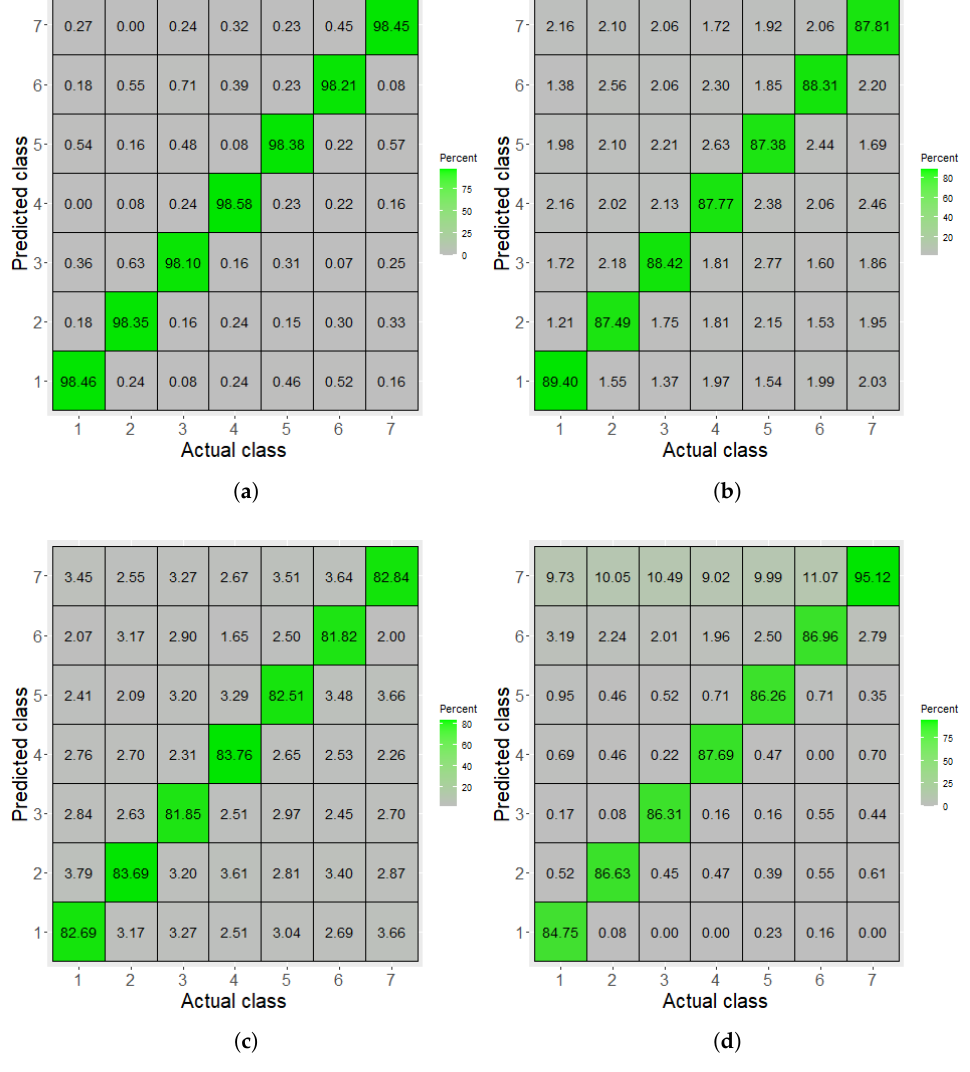
Figure 11. Confusion matrix of building façade classification in: ( a ) clear weather conditions; ( b ) rainy conditions; ( c ) partially blocked or in shadow. ( d ) shows the classification result from the Harward UAV dataset